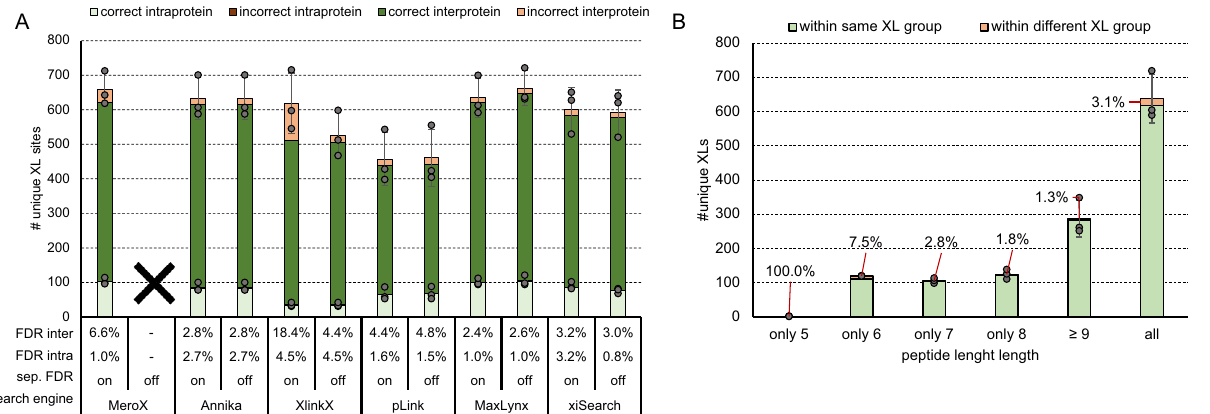
Fig. 5 Effect of separate inter/intra FDR calculation and minimal peptide length on FDR. A Average number of unique crosslinks from the DSSO crosslinked main library after acquisition using a stepped HCD MS2 strategy with separate FDR calculation for inter- and intra-crosslinked peptides set on or off. Although synthetic peptides were used for crosslinking their sequences are based on ribosomal protein sequences. “ Intraprotein ” are de fi ned as homomeric links and “ interprotein ” are heteromeric links based on the proteins the synthetic peptides correspond to. B Average number of crosslinks from the DSSO linked main library identi fi ed with MS Annika at 1% estimated FDR when fi ltering for crosslinked peptides of the given length (meaning the length of the shorter peptide within the crosslinked sequence). A and B Error bars indicate standard deviations of average values, experimentally validated FDR is shown as callout or in table format under the x-axis, n = 3 independent samples acquired on different days. Source data are provided as a Source Data fi le.